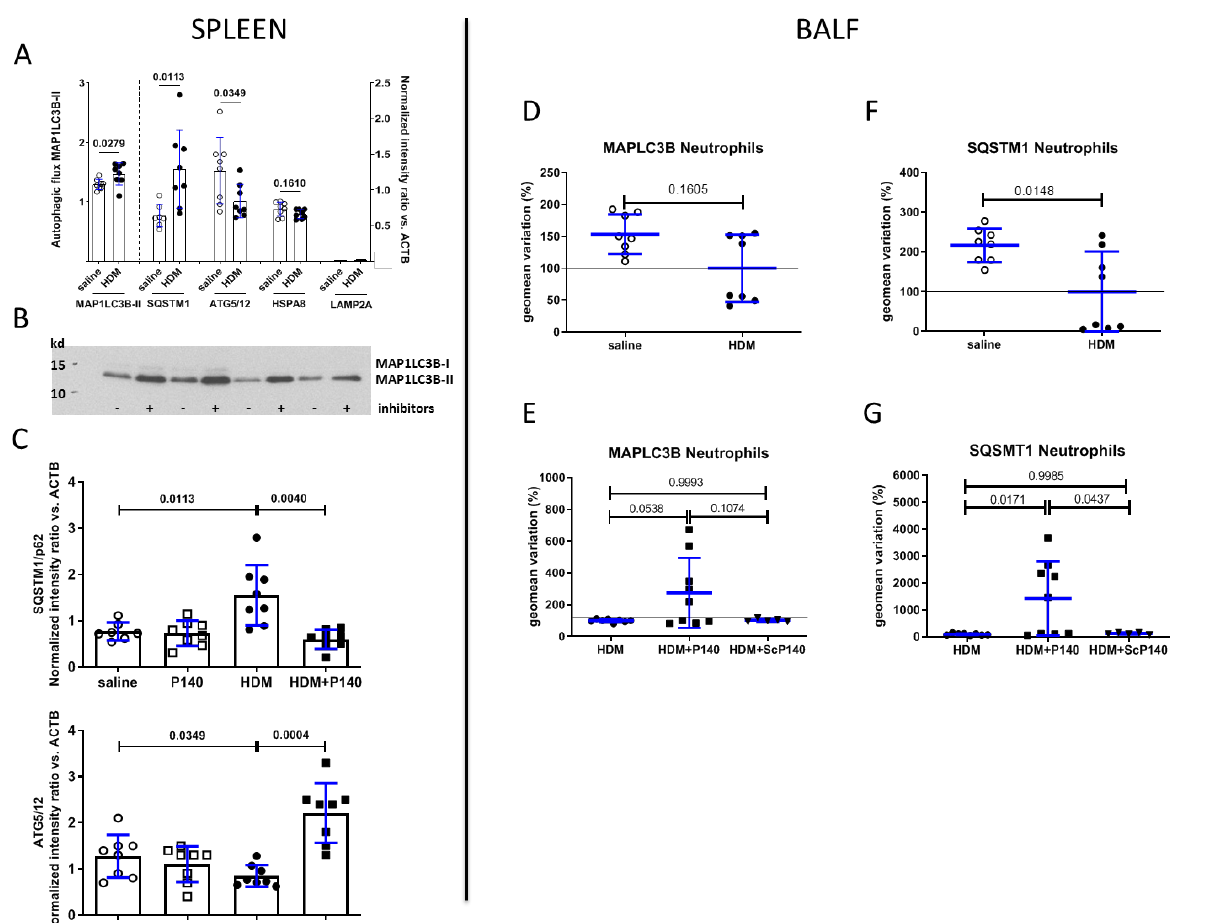
Figure 5. Measurement of autophagy markers in total splenocytes and BAL neutrophils collected from mice from HDM- sensitized and challenged mice. Nine-week-old female BALB/c mice were sensitized and challenged intranasally as indicated in Figure 2A. They receive vehicle, P140 or ScP140 intravenously at day 22; BALFs and spleens were collected at day 31. ( A , B ) Western immunoblotting and semi-quantification of five autophagy markers present in the spleen extracts from mice that received saline only or that were sensitized and challenged by HDM, and were treated or not with P140 ( n = 8 in each group). The data are presented as the mean ± SEM. In A, the autophagic flux (left part) corresponds to the ratio of MAP1LC3-II protein expression found in cells incubated in the presence or absence of bafilomycin A1. In A (right part) and C, the expression of the other proteins, as measured by densitometry of Western blots, was normalized with regard to the β -actin/ACTB level. ( D – G ) Flow cytometry semi-quantification of autophagy markers present in the neutrophil population present in the BALF from mice that received saline only or that were sensitized and challenged by HDM with or without treatment with P140. Two markers were tested, namely MAP1LC3B ( D , E ) and SQSTM1 ( F , G ). The results generated with other cell types are shown in the Figure S2. The data are represented as the mean variation ± SEM of the geomean (in%). The horizontal lines indicate the 100% level. Saline, n = 8; HDM, n = 8; HDM + P140, n = 9; HDM + ScP140, n = 5. Pooled data from 2 independent experiments.